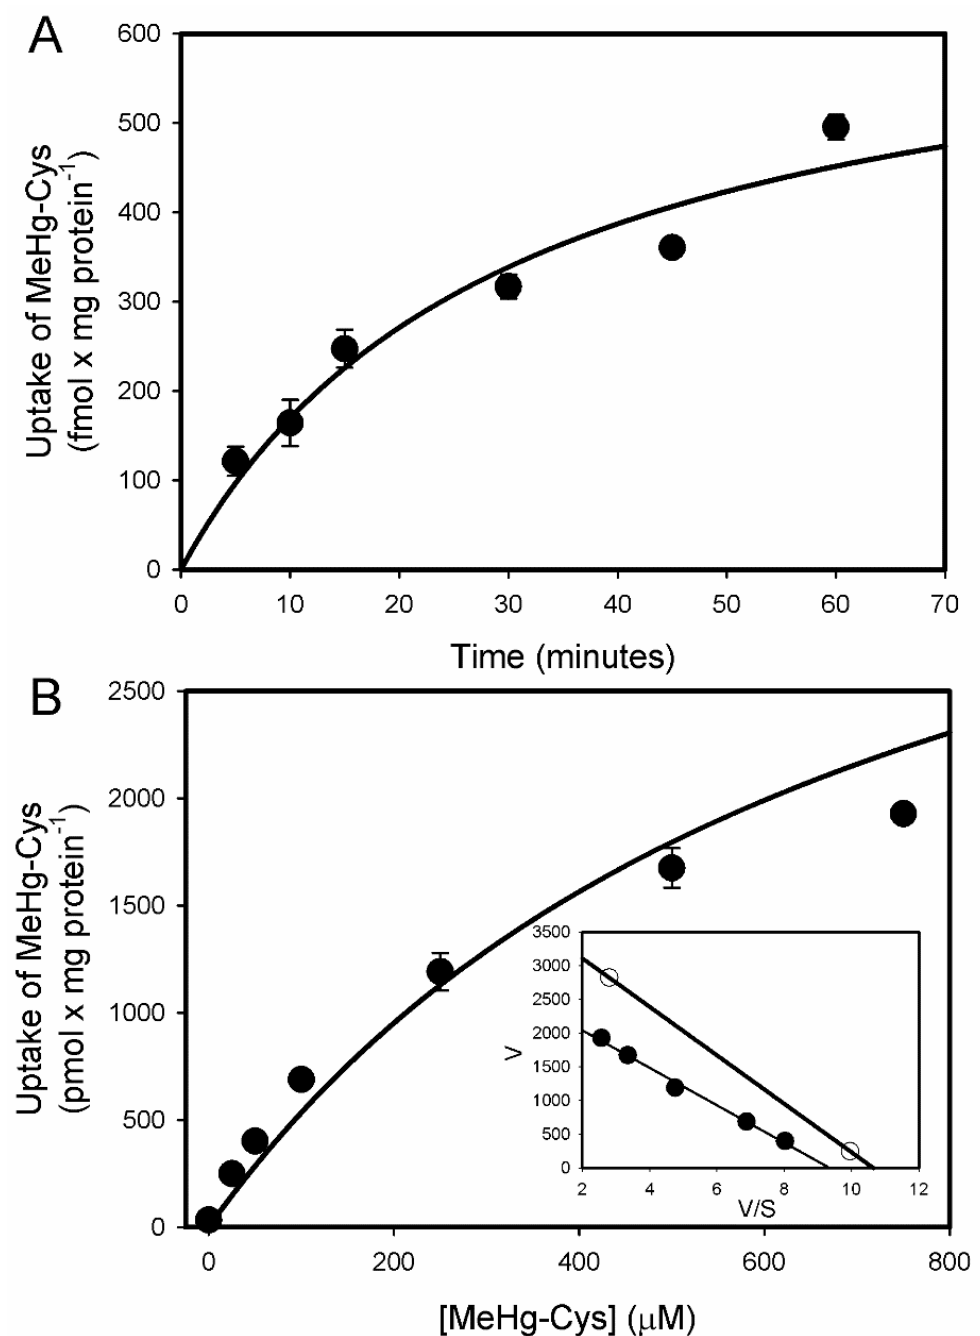
Figure 2. Time course of 5 µ M [ 14 C]-MeHg-Cys uptake in BeWo cells ( A ). Uptake was carried out at 37 °C for time periods ranging from 5 to 60 min. Saturation kinetics for the transport of [ 14 C]-MeHg- Cys ( B ) were assessed in BeWo cells (Inset: Eadie–Hofstee plot). Cells were incubated for 30 min with 5 µ M [ 14 C]-MeHg-Cys in the presence of unlabeled MeHg-Cys. Results are presented as mean ± SE. Data represent 3 experiments performed in triplicate.